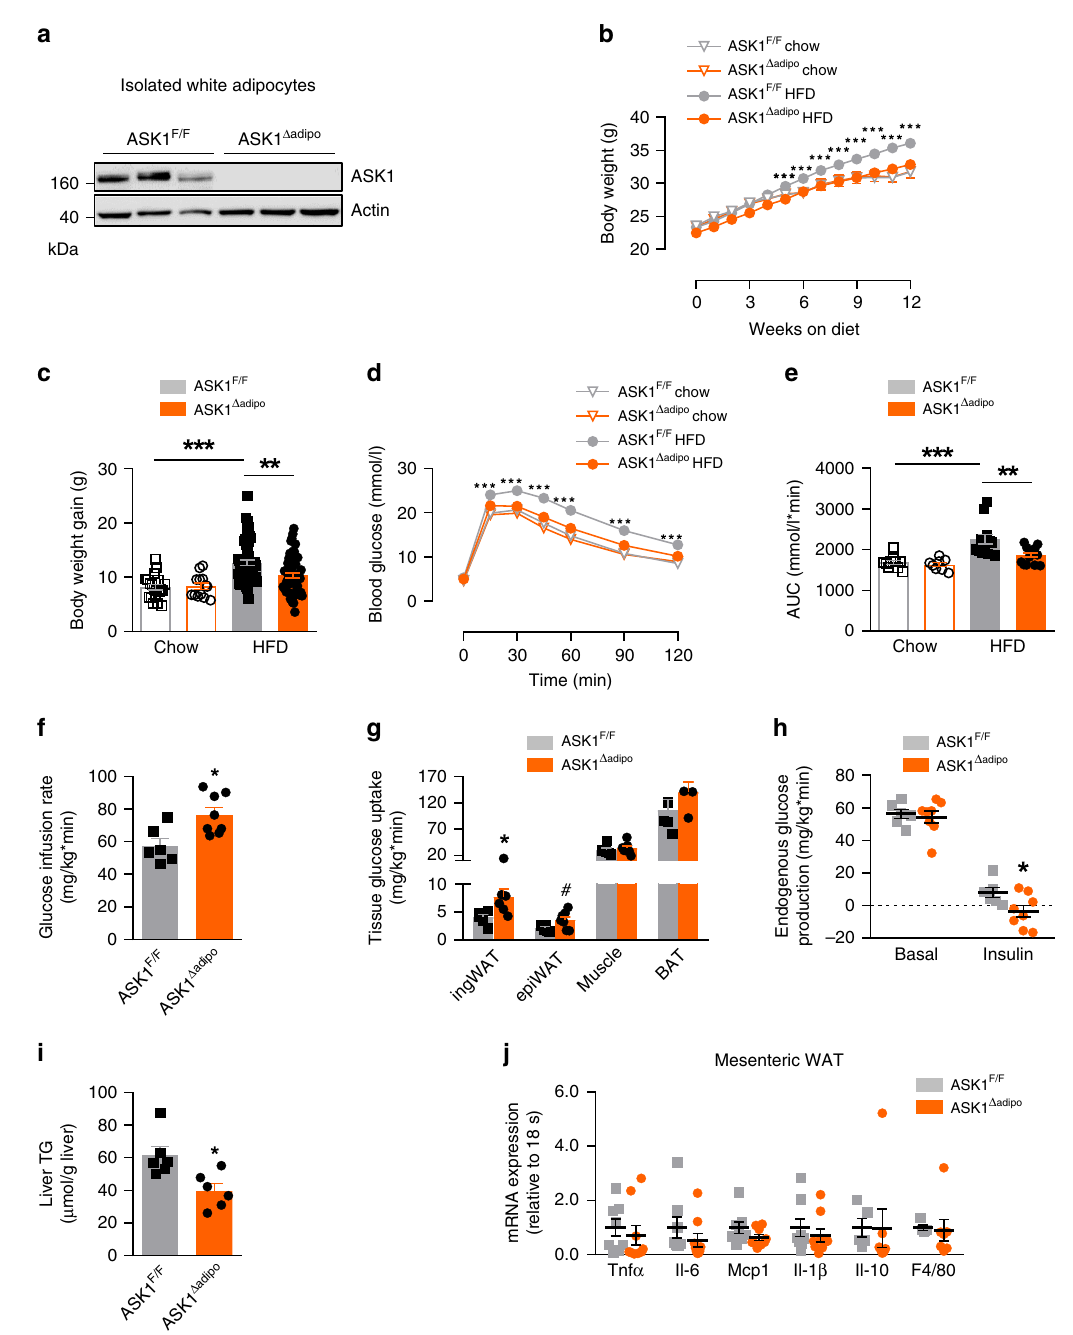
Fig. 2 Reduced body weight and improved glucose tolerance in HFD-fed ASK1 Δ adipo mice. a Protein levels of ASK1 in lysate of isolated epididymal adipocytes harvested from ASK1 F/F and ASK1 Δ adipo mice ( n = 3 mice per group). b , c Body weight and body weight gain during 12 weeks of chow (ASK1 F/F , n = 20 mice; ASK1 Δ adipo , n = 13 mice) or HFD feeding (ASK1 F/F , n = 52 mice; ASK1 Δ adipo , n = 58 mice). ** p = 0.02, *** p < 0.001. d , e Intraperitoneal glucose-tolerance test (chow-fed: ASK1 F/F , n = 10 mice; ASK1 Δ adipo , n = 8 mice; HFD-fed: ASK1 F/F , n = 13 mice; ASK1 Δ adipo , n = 14 mice) at 18 weeks of age. ** p = 0.03, *** p < 0.001. f Glucose infusion rate (GIR) during hyperinsulinemic-euglycemic clamps in HFD-fed ASK1 F/F ( n = 6) and ASK1 Δ adipo ( n = 8) mice. * p = 0.011. g Glucose uptake into respective tissues during hyperinsulinemic-euglycemic clamps in HFD-fed ASK1 F/F ( n = 5 (ing WAT, epiWAT and skeletal muscle) or n = 6 (BAT)) and ASK1 Δ adipo ( n = 4 (BAT), n = 6 (ingWAT) or n = 7 (epiWAT and skeletal muscle)) mice. * p = 0.034, # p = 0.062. h Endogenous glucose production (EGP) during hyperinsulinemic-euglycemic clamps in HFD-fed ASK1 F/F ( n = 6) and ASK1 Δ adipo ( n = 8) mice. * p = 0.040. i Liver triglyceride levels determined in HFD-fed ASK1 F/F ( n = 6) and ASK1 Δ adipo ( n = 6) mice. * p = 0.012. j Mesenteric adipose tissue mRNA expression of respective targets determined in HFD-fed ASK1 F/F ( n = 5 (Il-10, F4/80) or n = 8 (TNF α , Il-6, Mcp1, Il-1 β ) and ASK1 Δ adipo ( n = 7 (Il-10, F4/80) or n = 9 (TNF α , Il-6, Mcp1, Il-1 β )) mice. Values are expressed as mean ± SEM. Statistical tests used: two-sided t -tests for ( f , g ) (without adjustments for multiple comparisons), h , i ANOVA for ( b – e) . AUC: area under the curve. Source data are provided as a Source Data fi